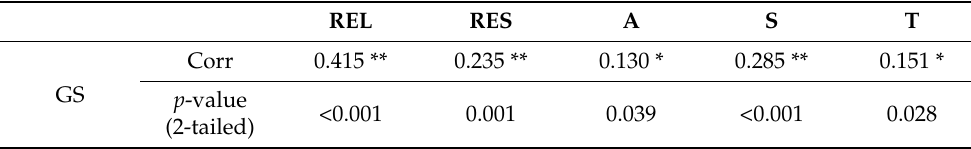
Table 5. Correlation coefficient matrix of the factors with general satisfaction. REL RES A S T Corr 0.415 ** GS p -value <0.001 0.001 0.039 <0.001 (2-tailed)